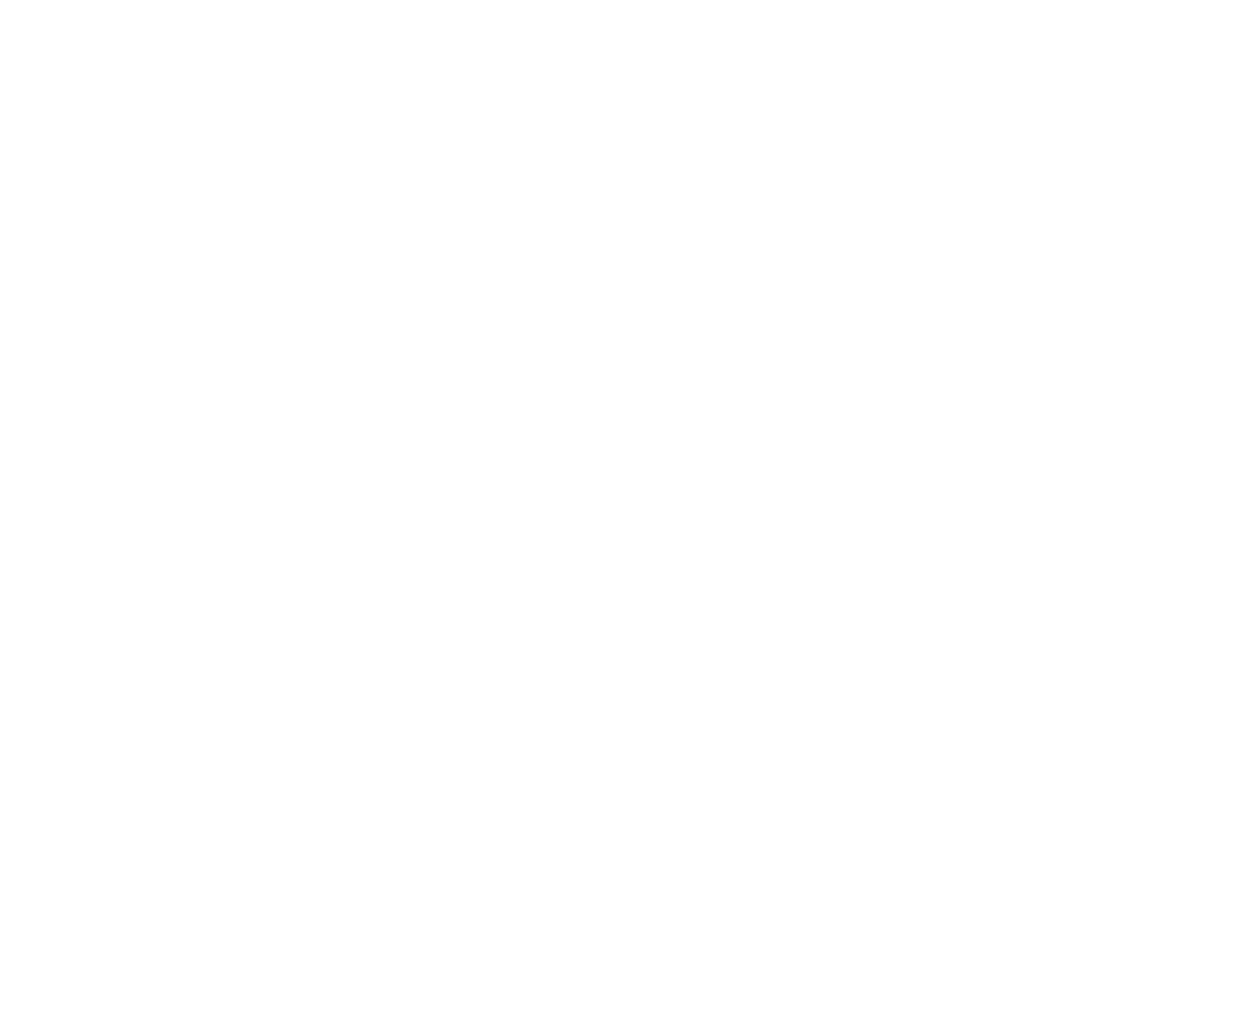
Frontiers in Genetics |